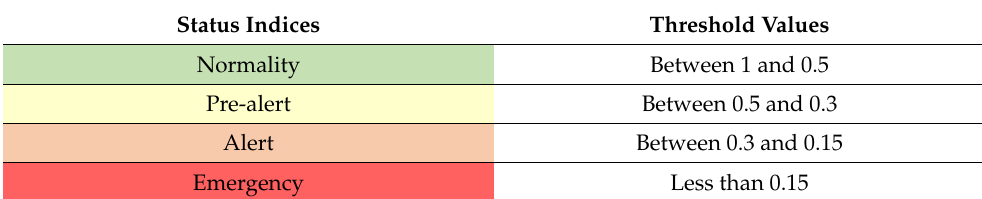
Table 12. Status indices and threshold values, temporary scarcity. Source: SDP 2018